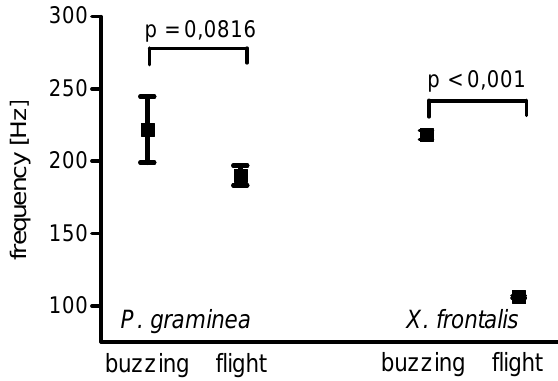
F IG . 2. Comparison of the buzzing and flight frequencies of the small Pseudaugochlora graminea ( Halictidae) (n = 3) and the big Xylocopa frontalis ( Apidae) (n = 18) (mean ± SD)